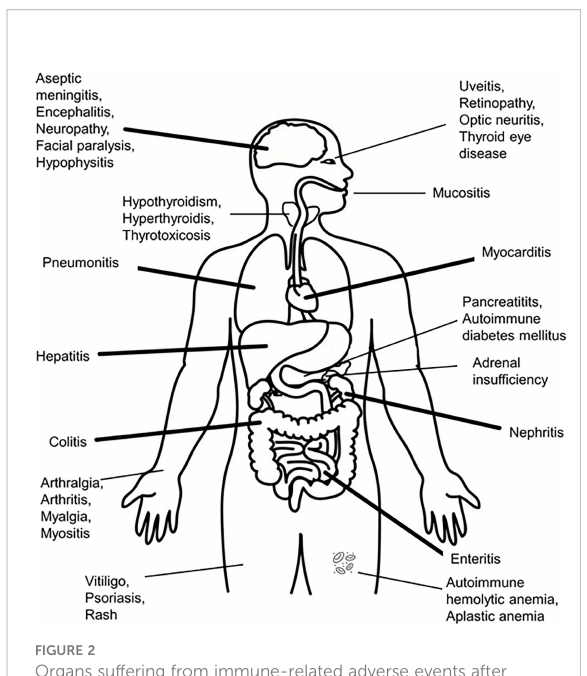
FIGURE 2 Organs suffering from immune-related adverse events after administration of immune checkpoint